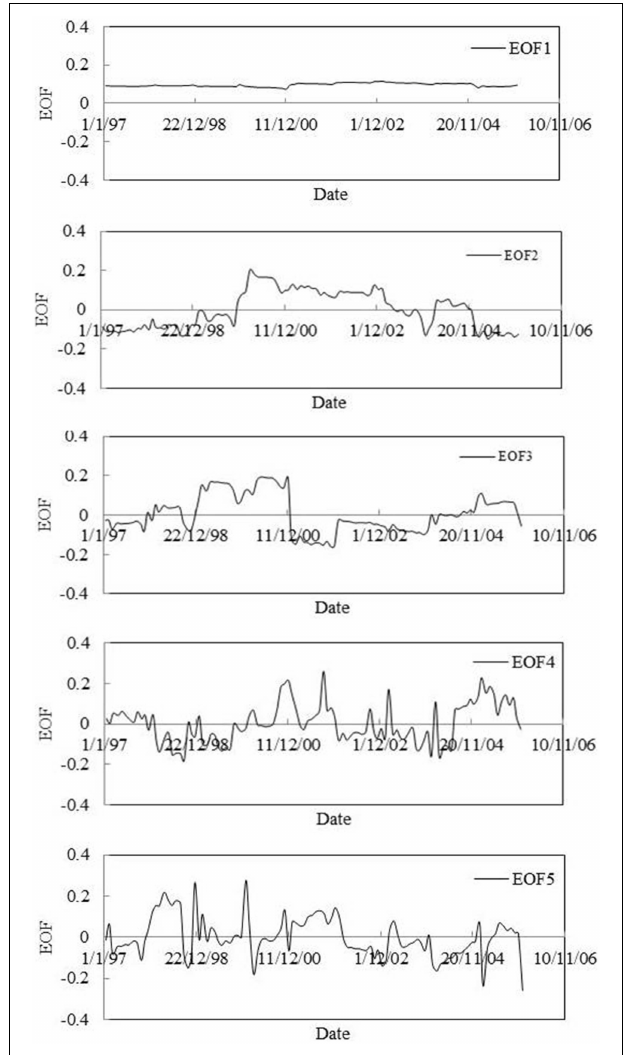
FIGURE 12 | Temporal variation of the first five eigenfunction derived for J-O Coast beach profiles.